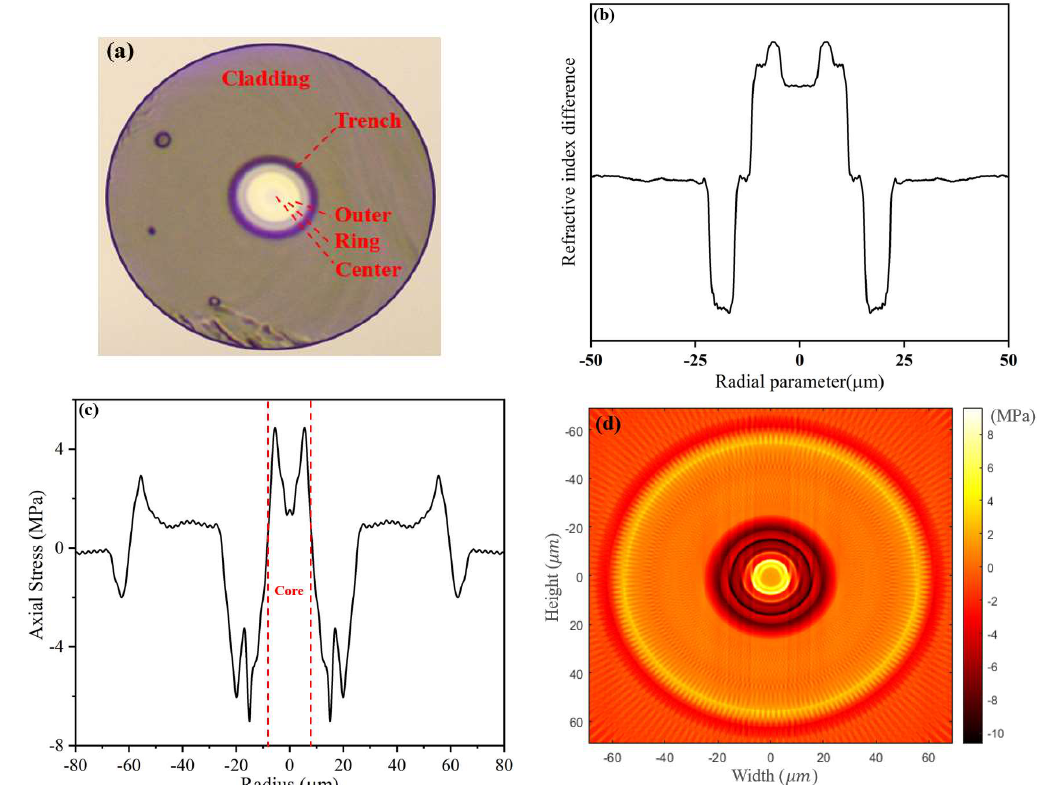
Figure 5. ( a ) Cross section, ( b ) RI profile, ( c ) and one-dimensional residual stress, and ( d ) two-di- mensional residual stress distributions on the cross section of passive FMF. dimensional residual stress distributions on the cross section of passive